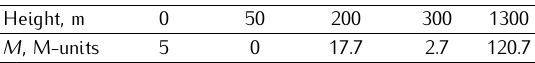
Table 3. Parameters for piecewise linear modified efractivity